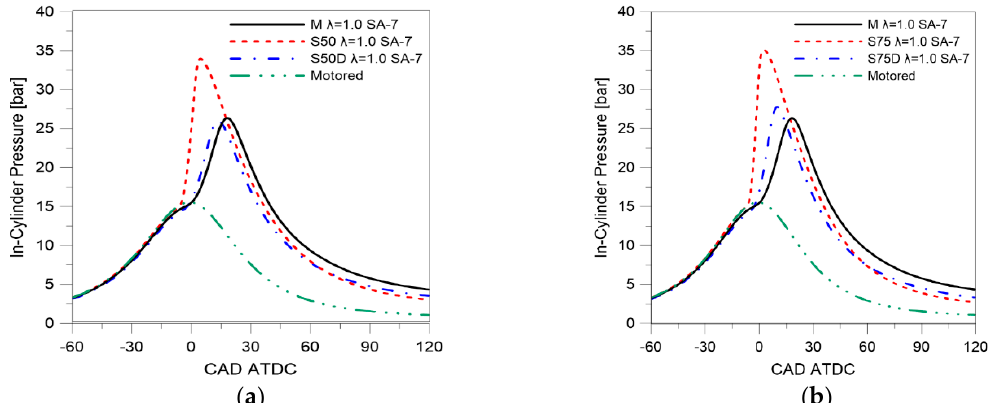
Figure 5. In-cylinder pressure traces averaged for stoichiometric fuelling ( λ = 1.0) for: ( a ) 50% H 2 blends and ( b ) 75% H 2 blends, compared with methane.